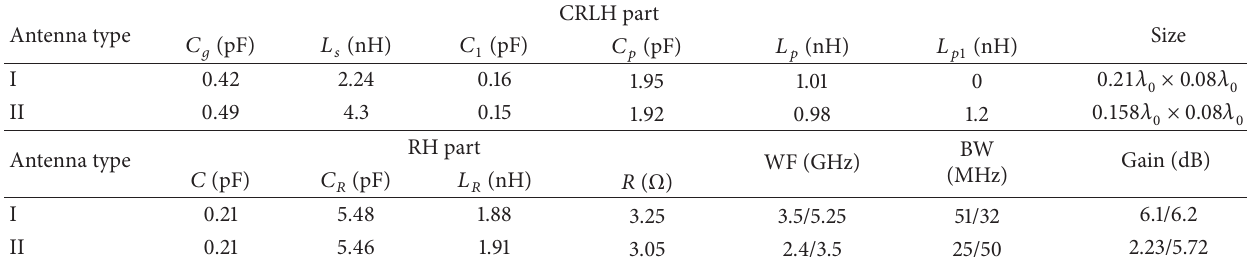
Table 1: Comparison of circuit parameters and performances for proposed two antennas.